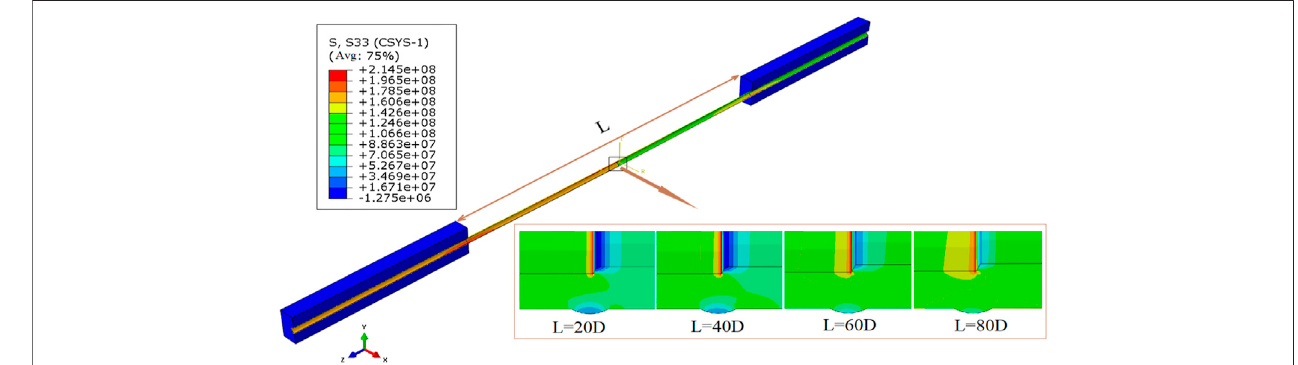
FIGURE 9 | Stress nephogram in fl uenced by suspension length.